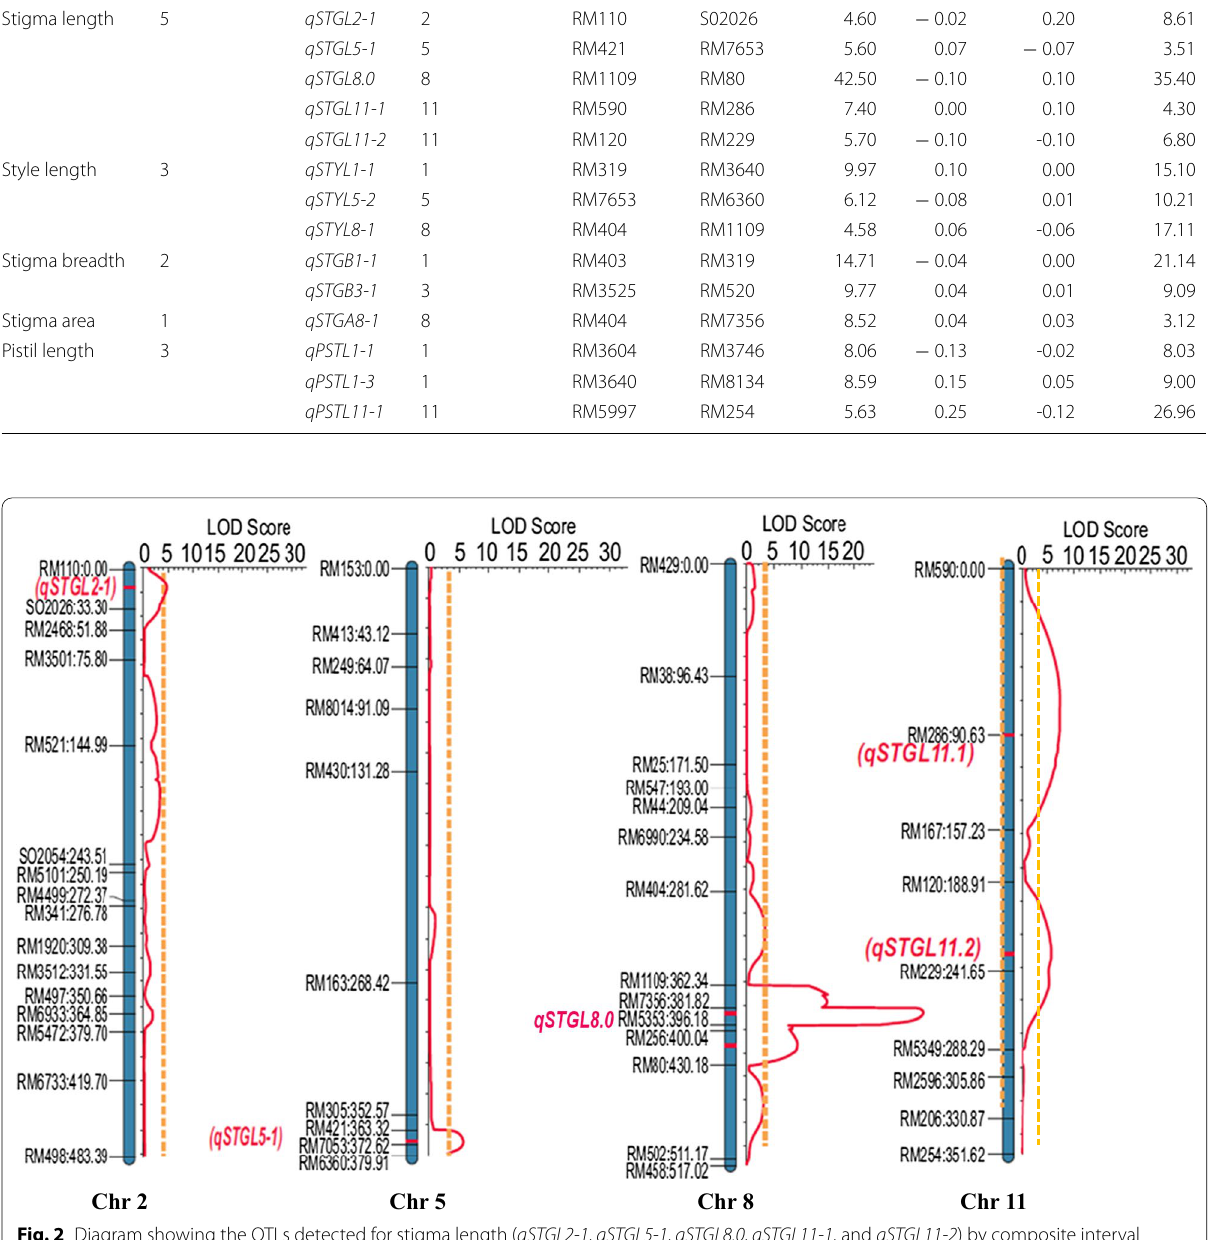
possessing OL alleles at qSTGL8.0 had long-exserted locus with 103 (IR58025B OL-IRGC110404) and 98 × stigma phenotype while the plants of the maintainer (IR68897B OL-IRGC92664) BC 1 F 1 plants. Marker- × lines had short-stigma phenotype in both backgrounds. trait association analysis revealed that the BC 1 F 1 plants